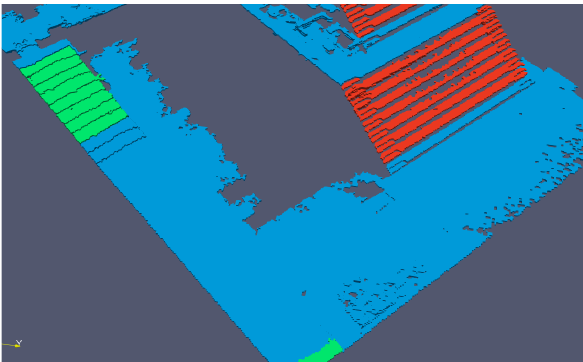
Figure 4. Regions in the voxel model: green represents a slope, blue represents a flat surface and red represents a stair